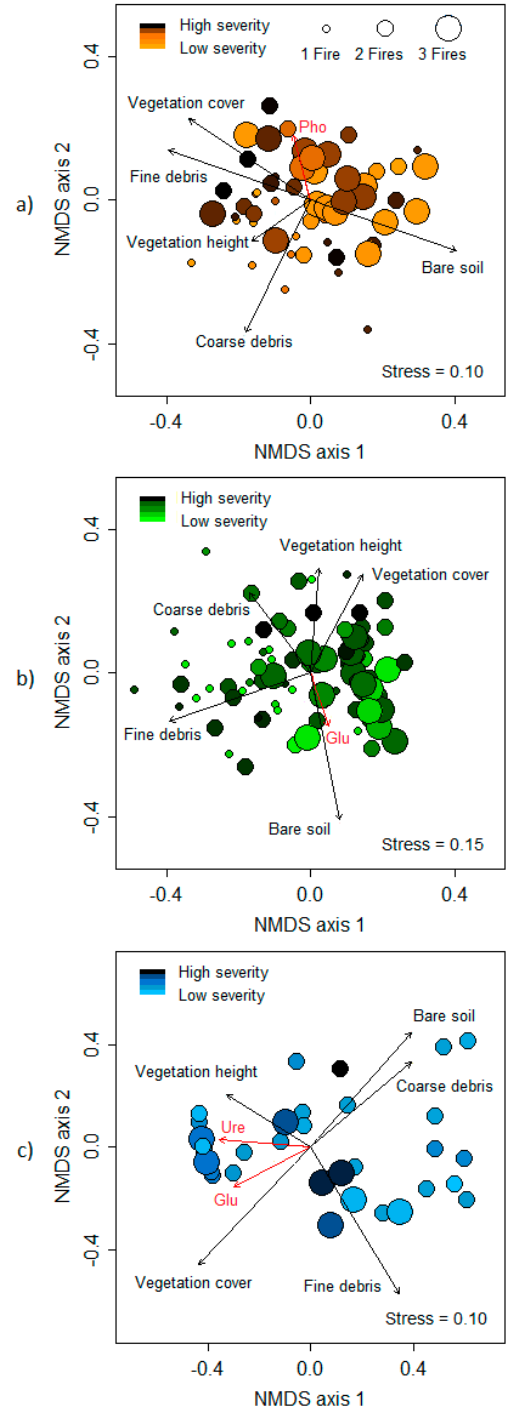
Figure 3. Non-metric multidimensional scaling ordination (NMDS) ordination of the plots from the three study sites (( a ) Mediterranean in orange, ( b ) Transition in green, and ( c ) Oceanic in blue) performed with the ecological variables represented by black vectors: percentage cover of (i) bare soil, (ii) fine, and (iii) coarse plant debris; (iv) vegetation; and (v) vegetation maximum height. The external variables β -glucosidase (Glu), urease (Ure), and phosphatase (Pho) activities, and microbial biomass C, were fitted to the NMDS (red vectors) and shown when significant. Shape size represents fire frequency (number of fires) and color ramp represents severity (dNBR of the last fire). See Table 3 for further information.